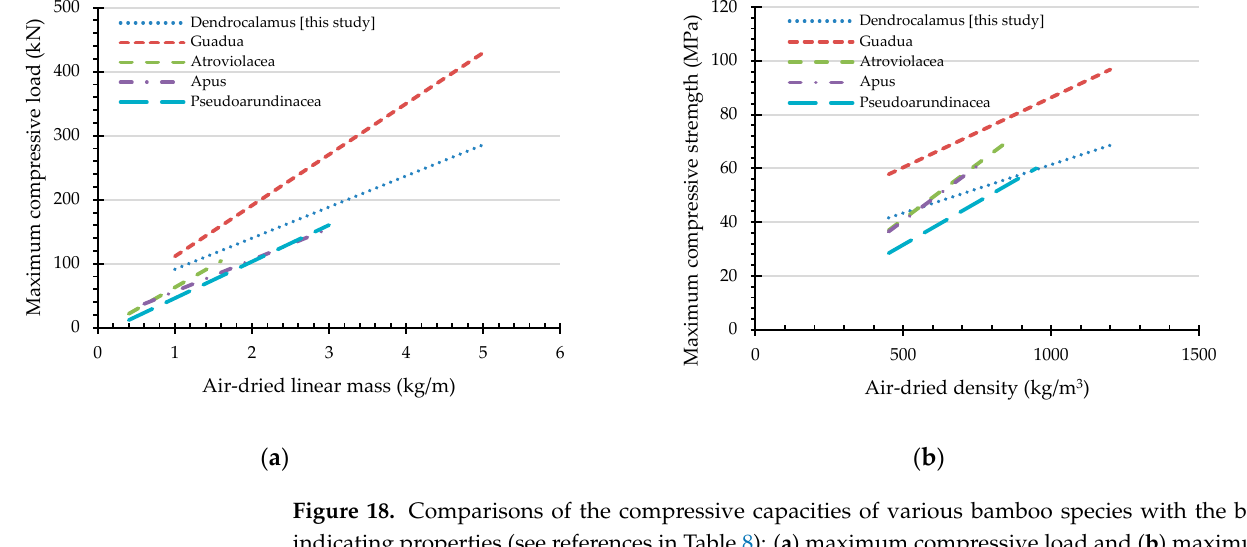
Figure 18. Comparisons of the compressive capacities of various bamboo species with the best indicating properties (see references in Table 8): ( a ) maximum compressive load and ( b ) maximum compressive strength.